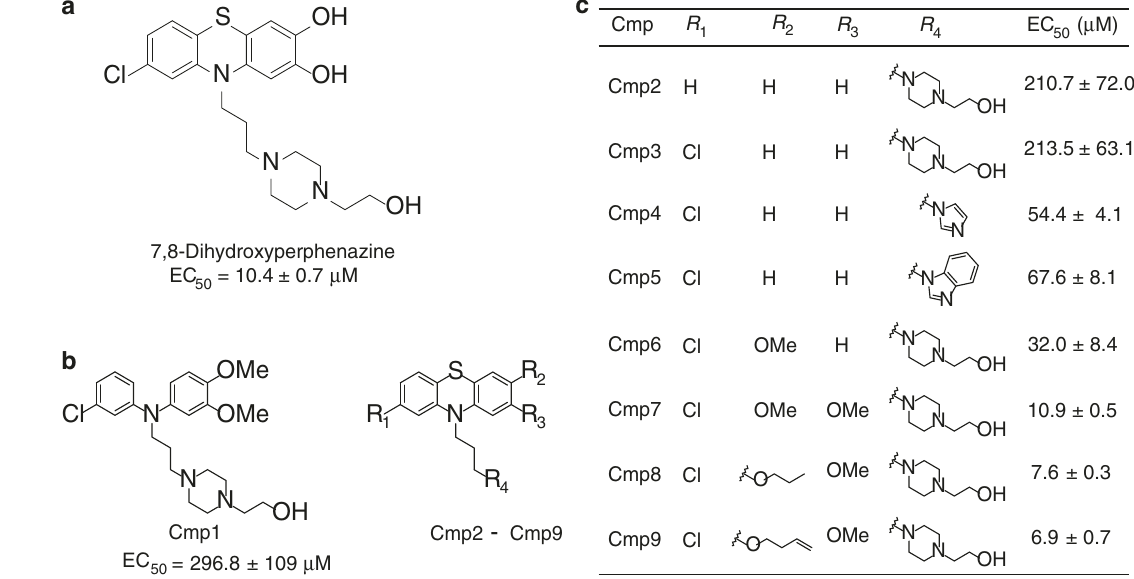
Fig. 2 SAR on 7,8-dihydroxyperphenazine. a Chemical structure of 7,8-dihydroxyperphenazine is shown. b, c SAR studies showing the af fi nity of each compound for SPF45 as determined by AlphaScreen assay. Errors represent standard error of fi tting ( n =